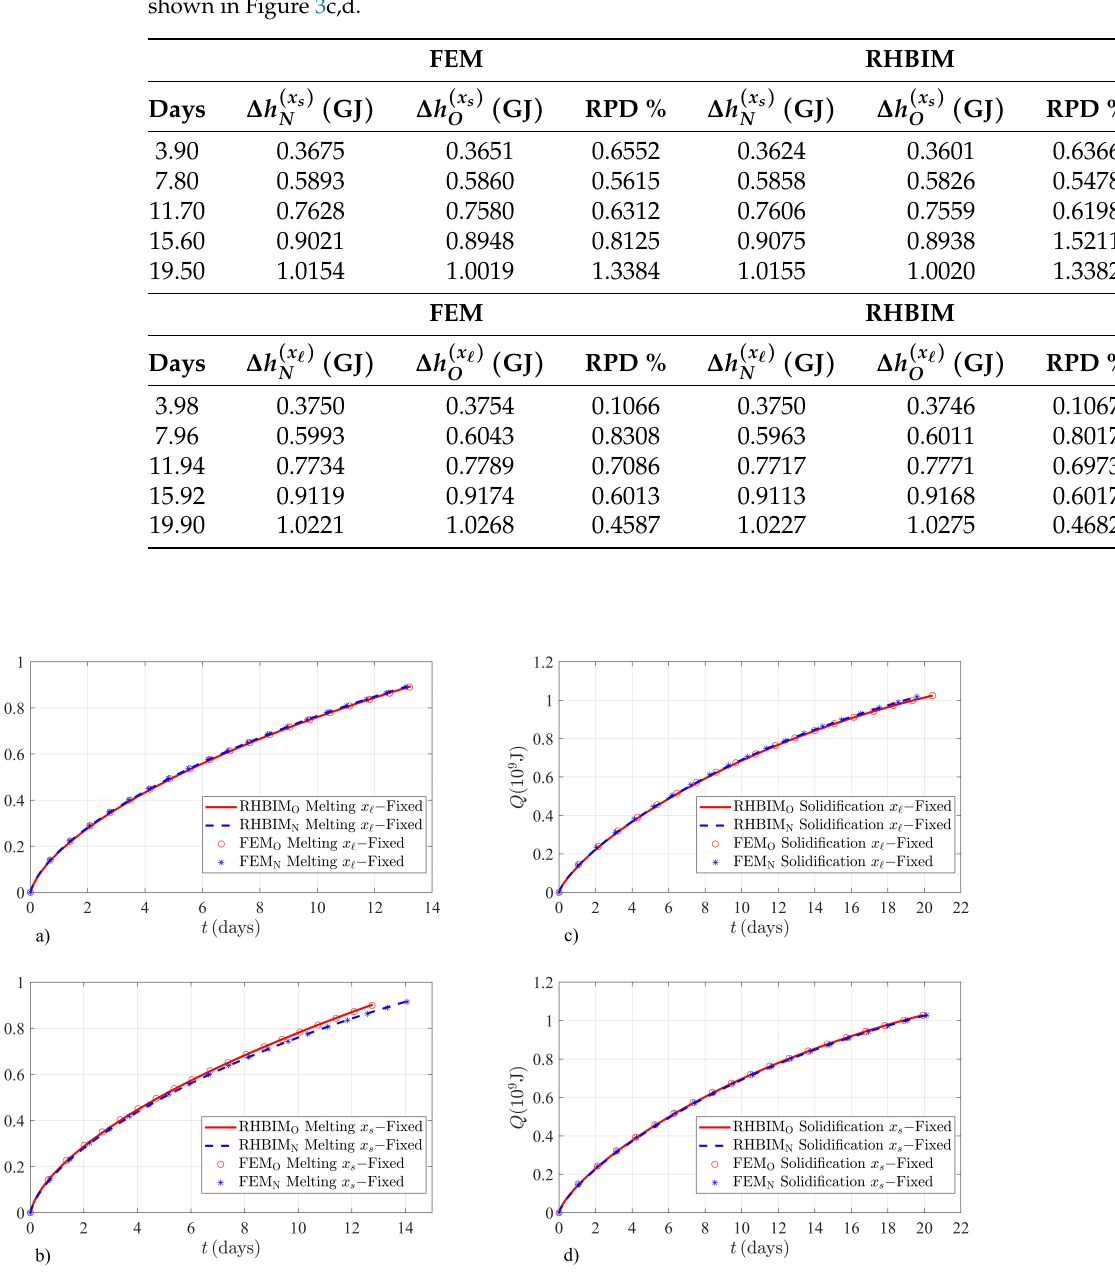
Figure 4. Finite element method and RHBIM solutions to the total energy absorbed and released by the KNO 3 /NaNO 3 salt. Solutions obtained from the old and new models are shown in each case. ( a ) Time evolution of the energy absorbed Q = h ( t ) − h ( 0 ) in GJ when x (cid:96) ( t ) is fixed in time. ( b ) Thermal energy absorbed Q when x s ( t ) is fixed. ( c ) Released energy Q = h ( 0 ) − h ( t ) during a discharge process when the left boundary is fixed in time. ( d ) Thermal energy released when x s ( t ) is constant in